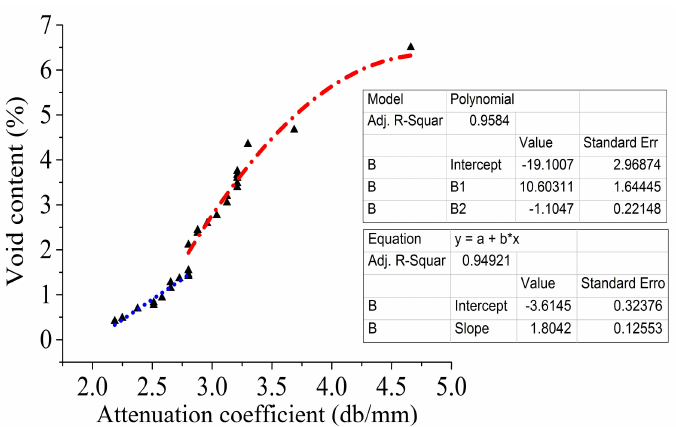
Figure 8. The relationship between the void content and the attenuation